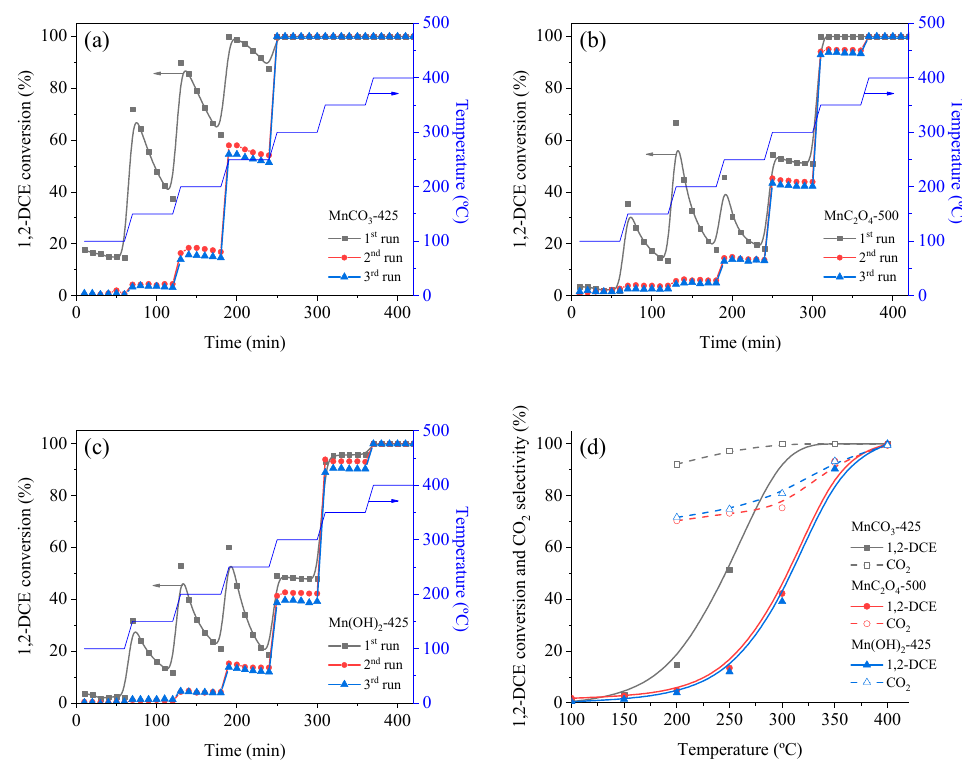
Figure 10. Catalytic evaluation of the ( a ) MnCO 3 -425, ( b ) MnC 2 O 4 -500 and ( c ) Mn(OH) 2 -425 catalysts for the 1,2-DCE oxidation. ( d ) 1,2-DCE conversion and CO 2 selectivity of the MnCO 3 -425, MnC 2 O 4 -500 and Mn(OH) 2 -425 catalysts as a function of the temperature. (100 ppm 1,2-DCE / 20 vol% O 2 / N 2 ; 200 mg catalyst; WHSV 30,000 mL · g − 1 · h − 1